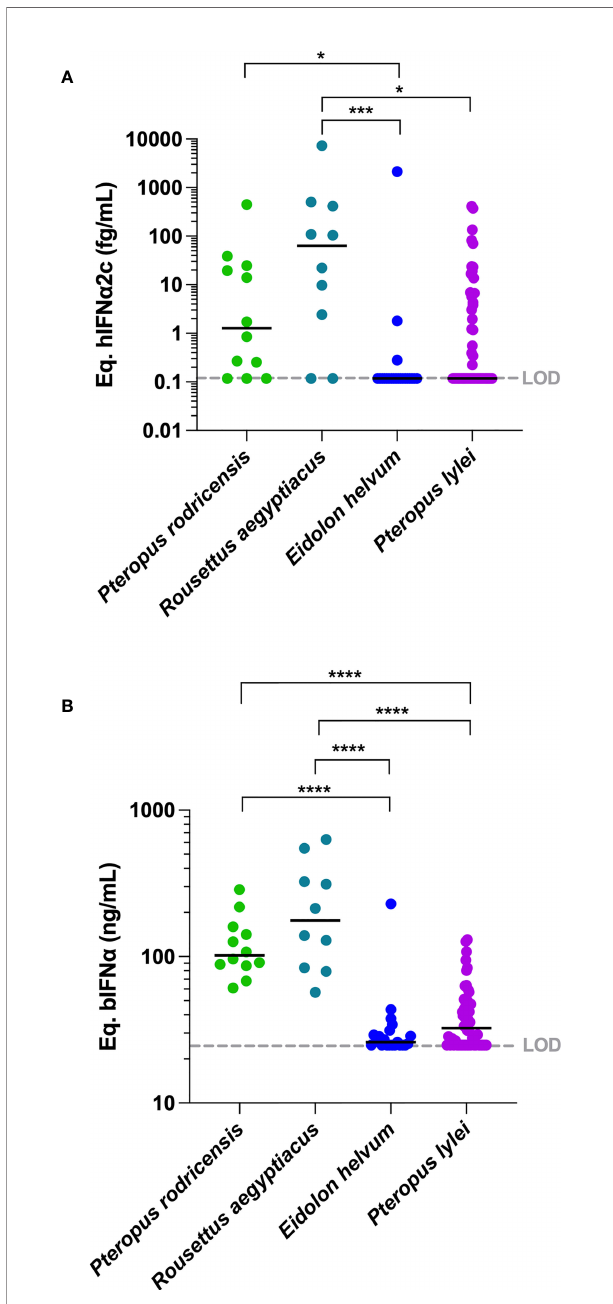
FIGURE 2 | IFN a protein concentrations in plasma of four bat species. IFN a concentrations measured in plasma from four bat species expressed (A) as hIFN a 2c or (B) as bIFN a equivalent concentrations. To allow comparisons, hIFN a 2c equivalent concentrations were performed for healthy humans, humans with systemic lupus erythematosus (SLE) and humans with dengue. LOD is the limit of detection level of the assay. Median represented by black line with individual animals shown by colour coded dots. Kruskal – Wallis test with Dunn ’ s post testing for multiple comparisons was used, *p < 0.05, ***p < 0.001, ****p < 0.0001. P . rodricensis (green, n=12), R. aegyptiacus (light blue, n=10), E. helvum (dark blue, n=21), P. lylei (purple, n=52), healthy humans (light grey, n=20), humans with SLE (grey, n=24) and humans with dengue (black,